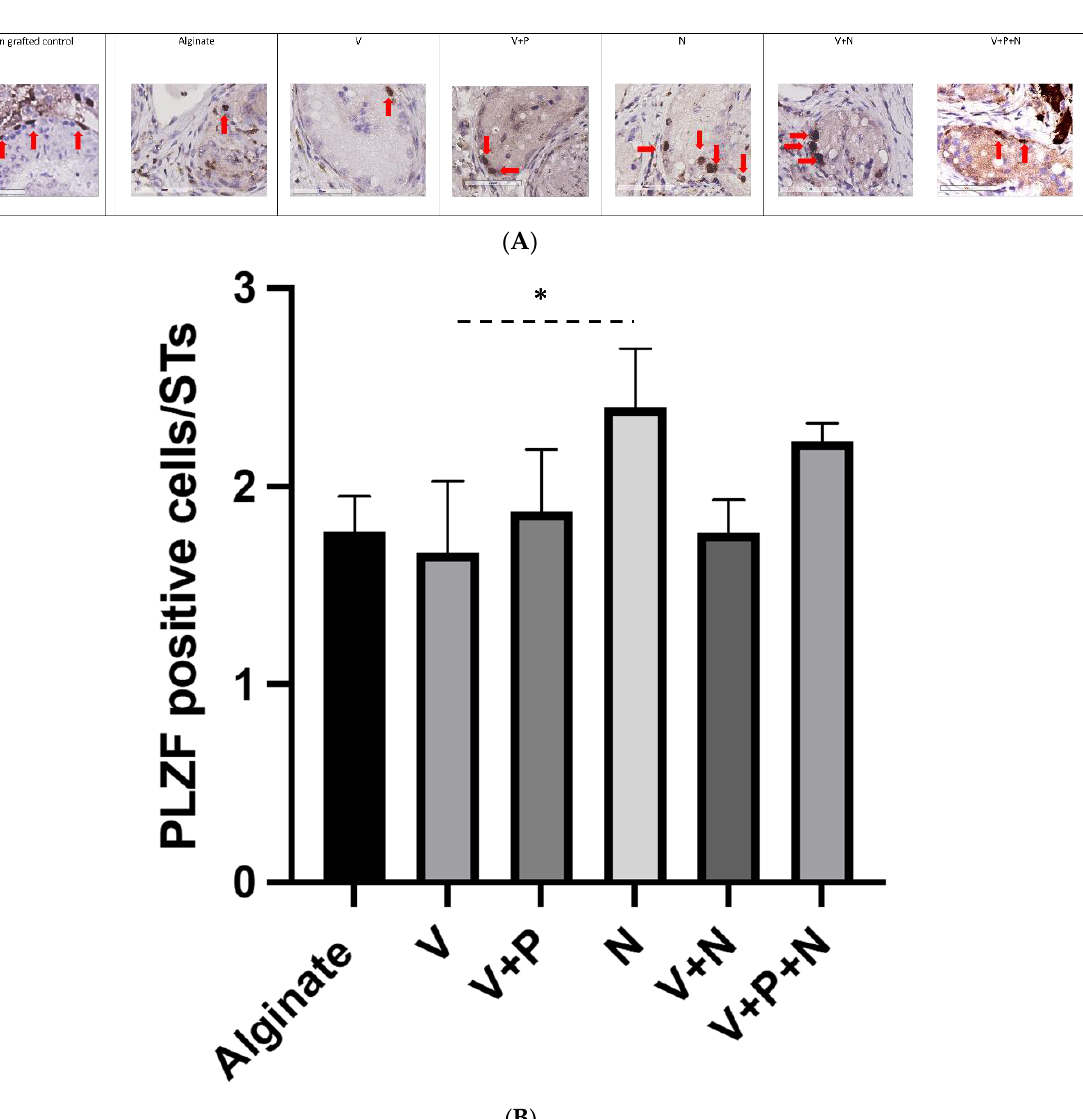
Figure 3. Impact of NP supplementation on germ cell survival 21 days after grafting. Mouse testicular tissue fragments were encapsulated in alginate supplemented with five different combinations in addition to a negative control (Alginate, V, V+P, N, V+N and V+P+N). ( A ) Immunostaining against PLZF was used to identify undifferentiated spermatogonia, (Red arrows highlight positive cells, scale bar = 60 μm) and ( B ) to quantify them. Results are expressed as the mean PLZF positive cells/STs (Alginate 1.77 ± 0.17; 1.79 ± 0.46; V+P: 1.87 ± 0.31; N: 2.4 ± 0.29; V+N. 1.76 ± 0.16; and V+P+N: 2.23 ± 0.08) ( n = 3). * p = 0.03